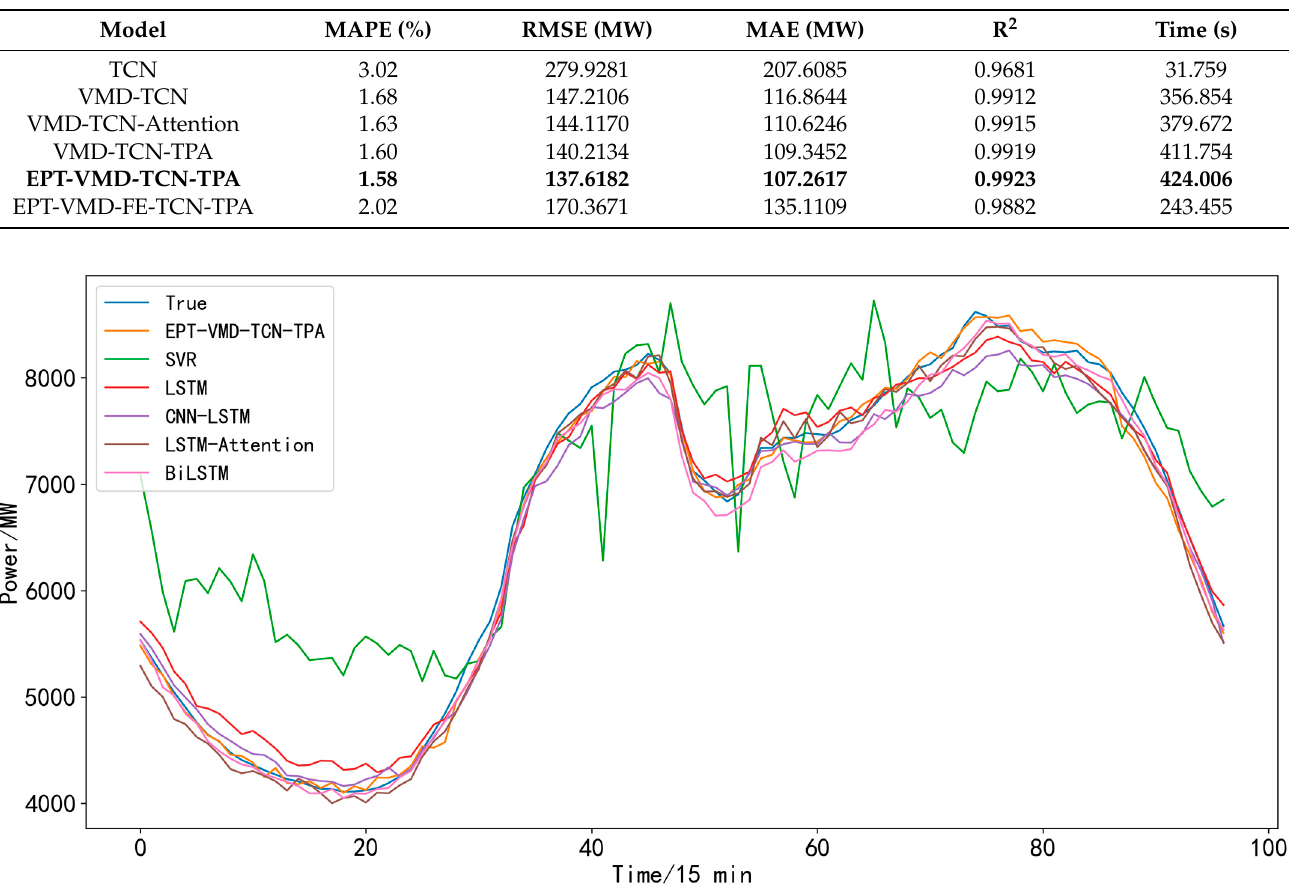
Figure 22. Area 2 prediction results for each model. Table 13. Area 2 evaluation indicators for each model .